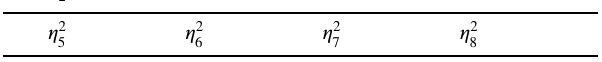
Fig. 4 Changes of the comprehensive evaluation elements vs.